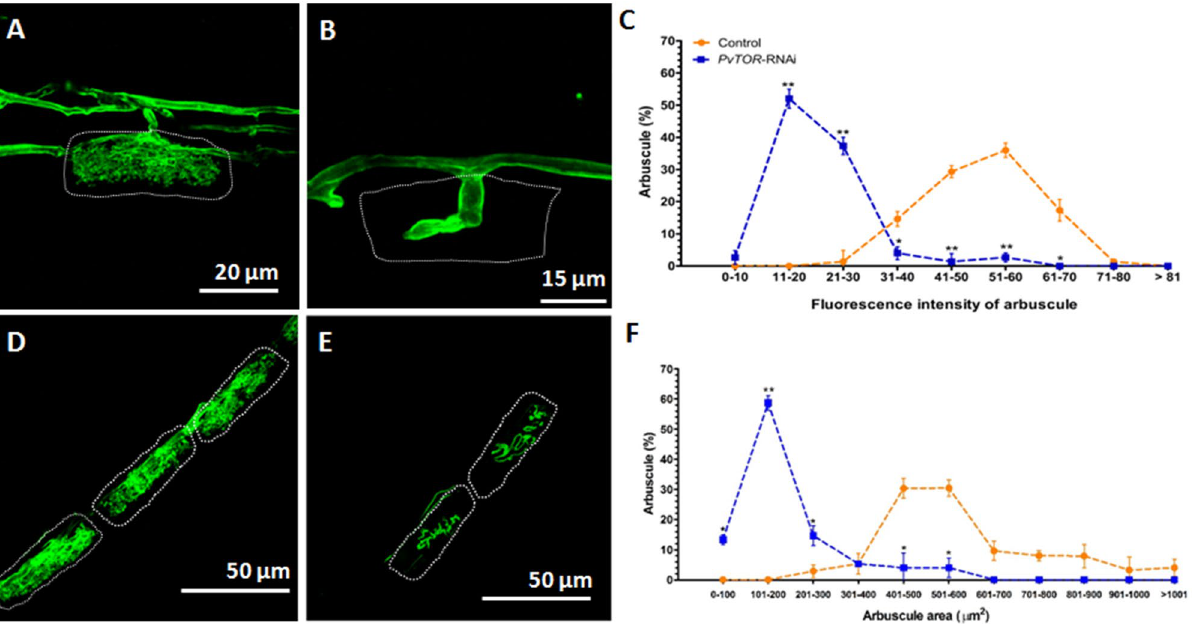
Figure 7. Analysis of arbuscule size in P. vulgaris PvTOR -RNAi roots colonized by R. irregularis . ( A-B ) Confocal images of R. irregularis arbuscules stained (green) with wheatgerm agglutinin (WGA) conjugated with Alexa Fluor 488 in the cortex cells of control ( A ) and PvTOR -RNAi ( B ) bean plants. ( C ) Frequency of the fluorescence pixel intensity in arbuscule populations measured in control and PvTOR -RNAi transgenic roots at 3 weeks post inoculation. (D–E) Confocal images of arbuscules stained with WGA conjugated with Alexa Fluor 488 in the cortex cells of control ( D ) and PvTOR -RNAi ( E ) bean plants. Dotted lines mark the arbuscule area. ( F ) Frequency of the distribution of the arbuscule area in arbuscule populations measured in control and PvTOR -RNAi transgenic roots. For C and F, mean values of 25 arbuscules per composite plant and a total of three plants are shown. The statistical significance of differences between control and PvTOR -RNAi roots was determined using an unpaired two-tailed Student’s t -test (* P < 0.05; ** P < 0.01). Error bars refer to the SE of the mean.